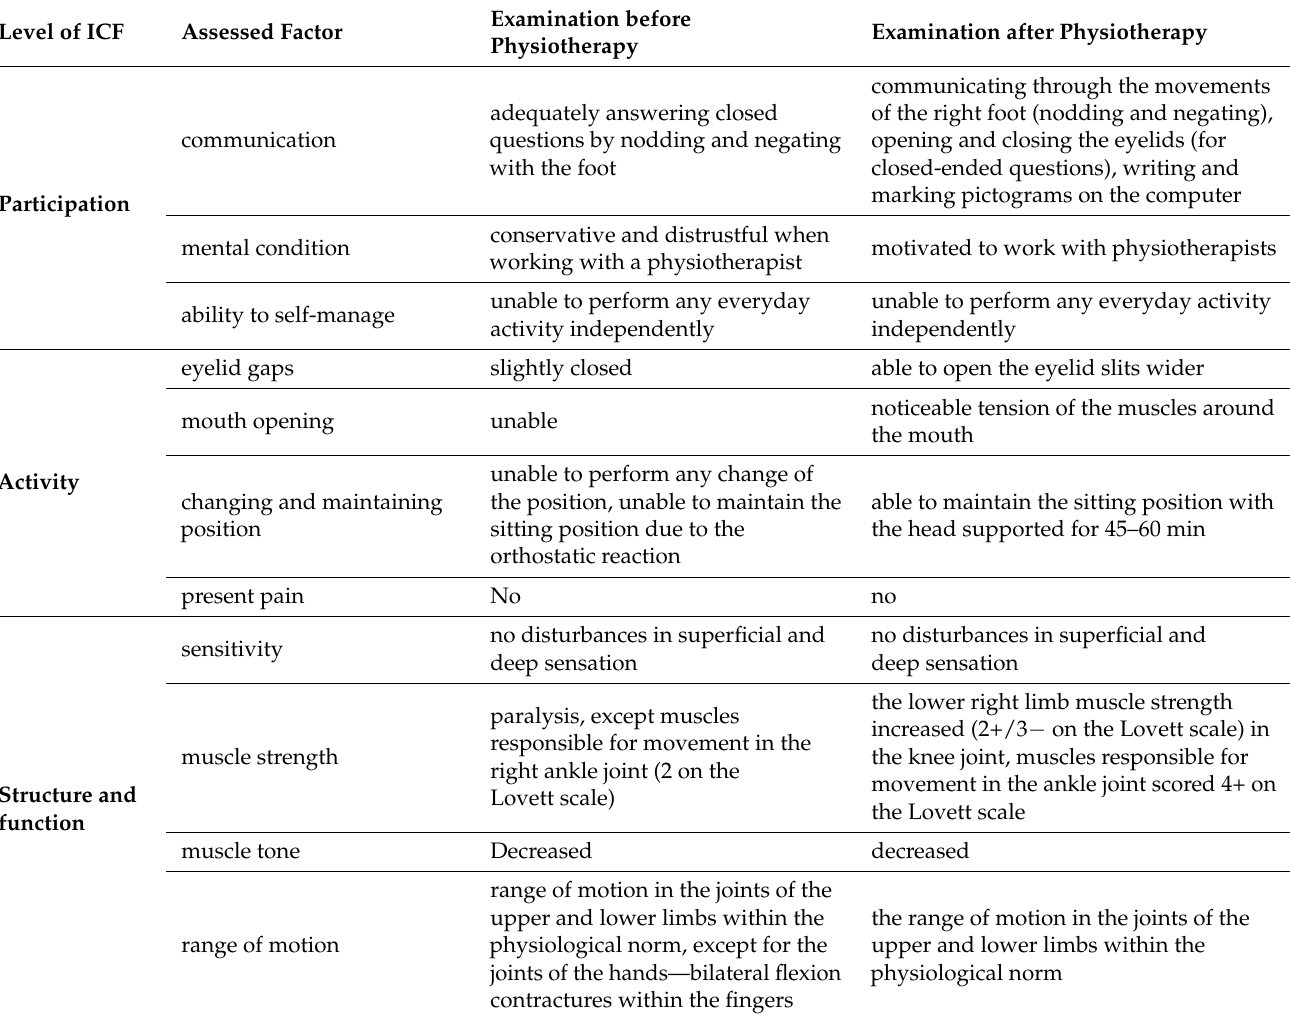
Table 1. Comparison of the main factors included in the examination before and after the cycle of